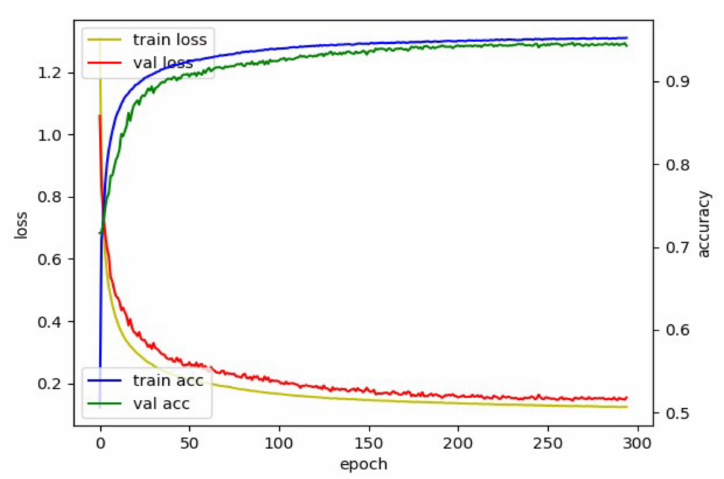
Figure 7. Loss and accuracy plot for model with pelvis input.